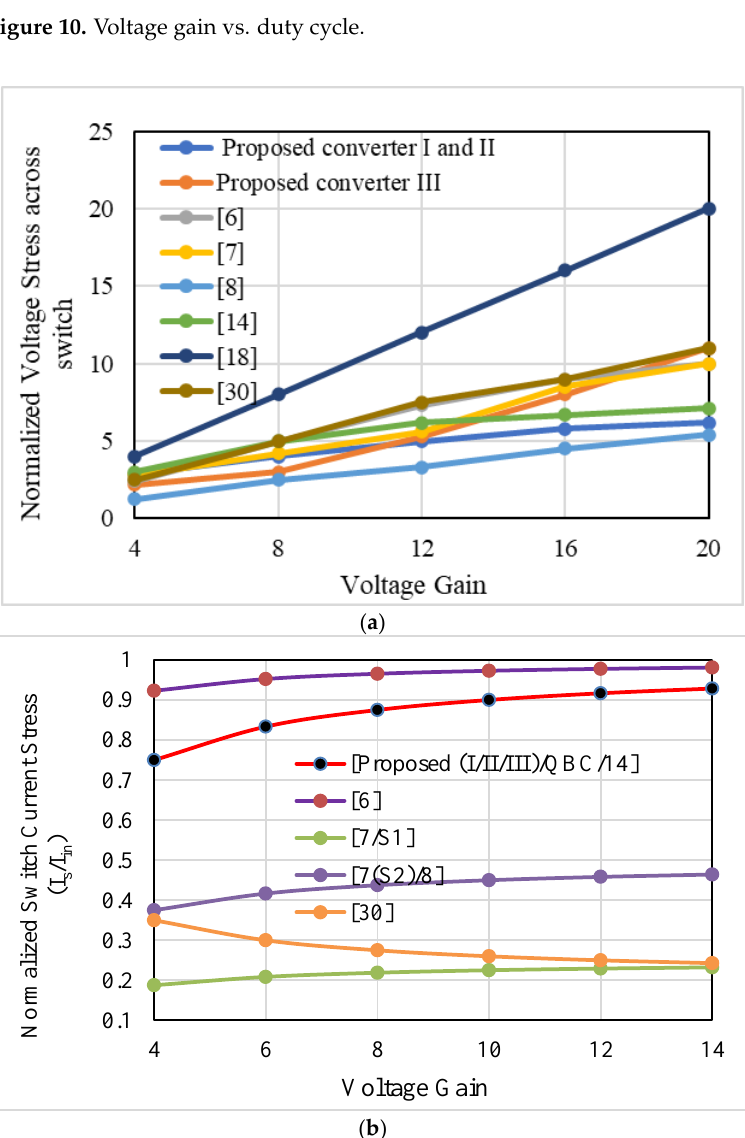
Figure 11. ( a ) Voltage stress vs. voltage gain. ( b ) Normalized current switch stress vs. voltage gain.